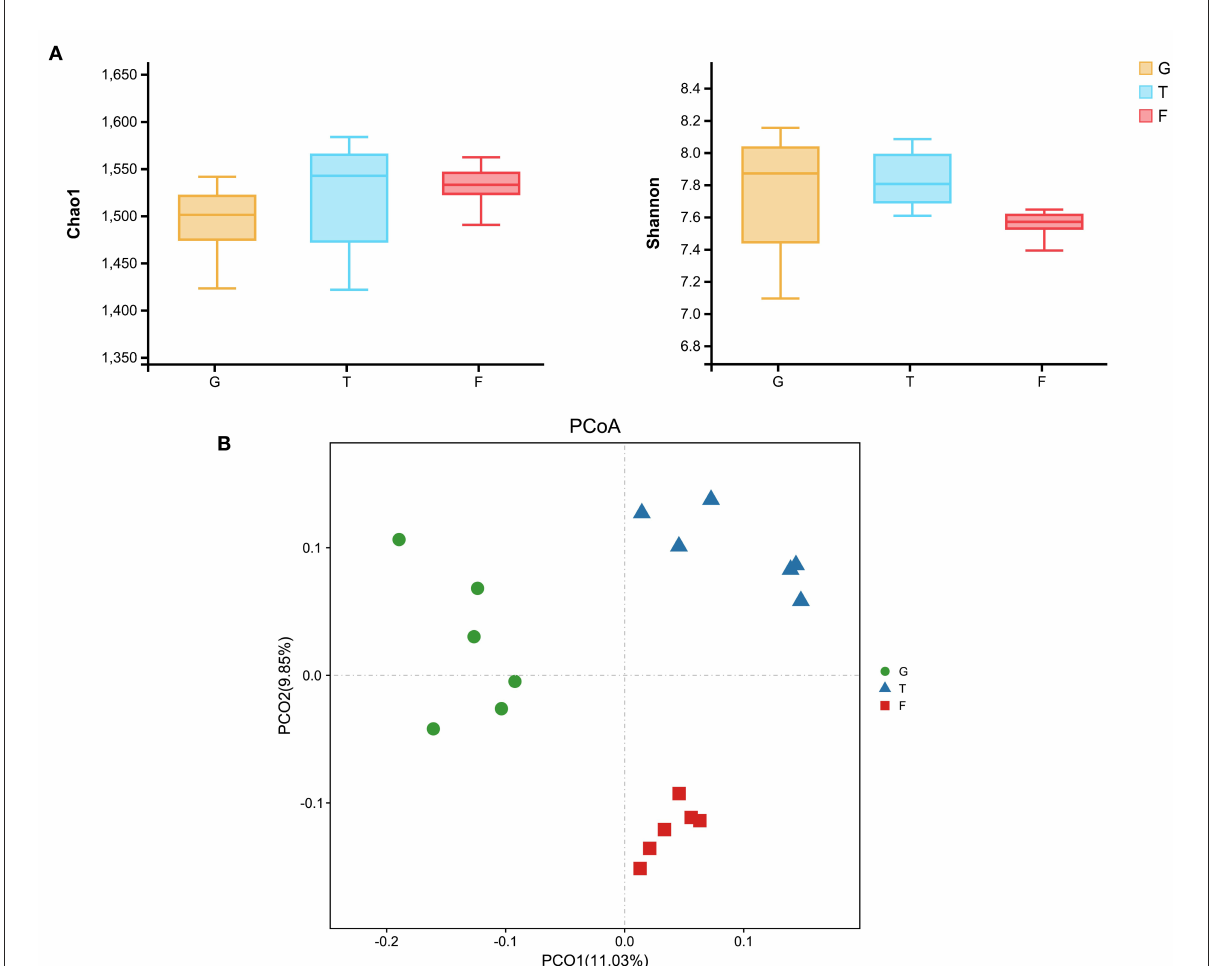
FIGURE1 Effects of feeding strategies on ruminal microbiota of Gangba sheep. (A) The richness and diversity indices of rumen microbiota in Gangba sheep under different feeding strategies. (B) Principal coordinates analysis (PCoA) of the overall rumen microbiota in Gangba sheep based on unweighted UniFrac distance. G, natural grazing; T, semi-grazing with supplementation; F, barn feeding.